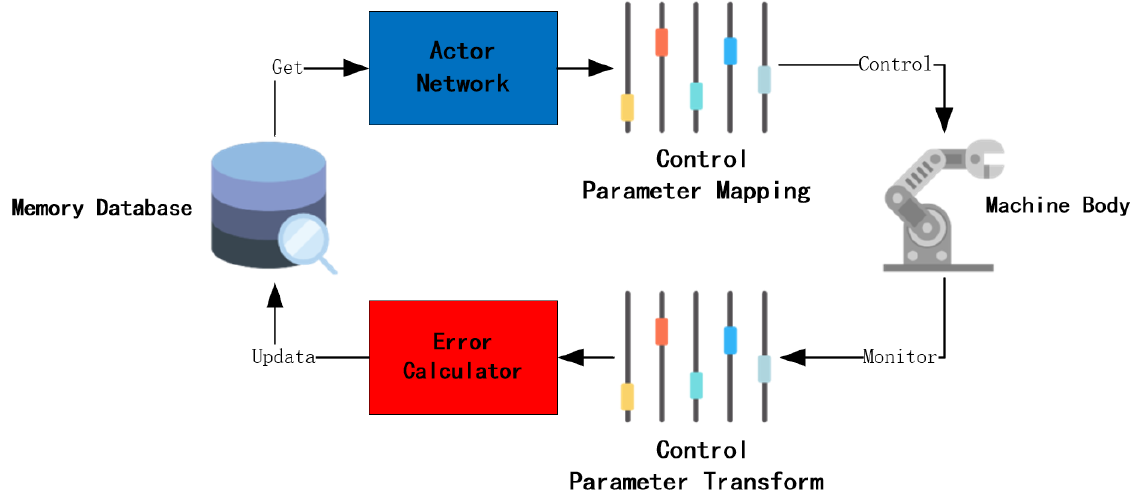
Figure 1. DDPG network control structure chart.